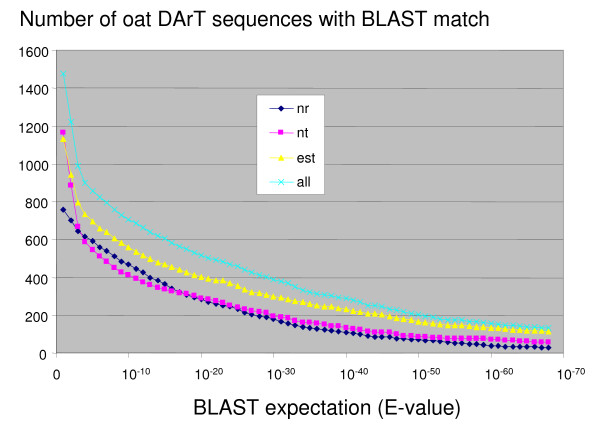
BLAST similarity. Number of non-redundant DArT clone sequences (consensus from contigs plus singletons) from a set of 1774 with BLAST hits having E-values smaller (more significant) than a given value when tested against the non-redundant nucleotide database (nt), the non-redundant protein database (nr), the EST database (est) or the concatenation of all three (all). All BLAST databases were downloaded from NCBI [33] on May 6, 2008, and searches were performed locally using BLASTX and BLASTN 2.2.18 [47]